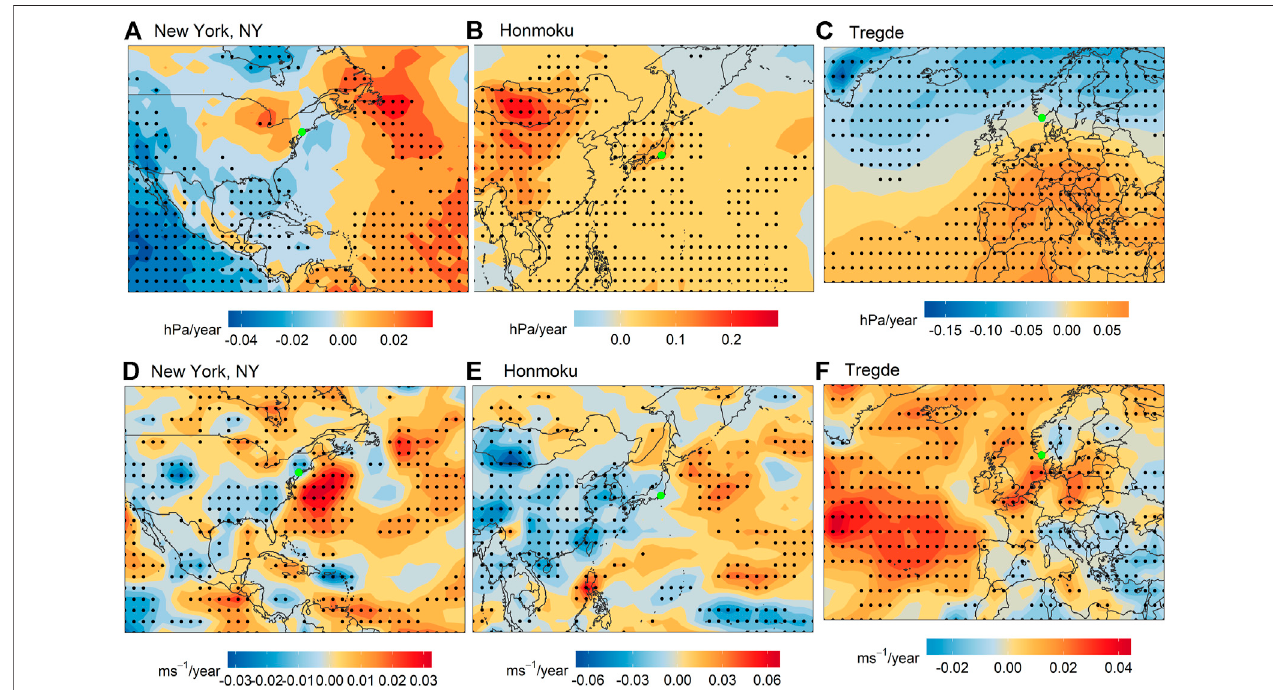
FIGURE 10 | Trends in (A – C) sea level pressure (hPa/year) and (D – F) wind speed (ms − 1 /year) during storm surge under extreme precipitation in tide gauge New York, NY (A, D) , Honmoku (B, E) , and Tregde (C, F) . Locations of the tide gauges interested are denoted by the green spots. Stippled regions represent areas with signi fi cant trends ( α (cid:1)